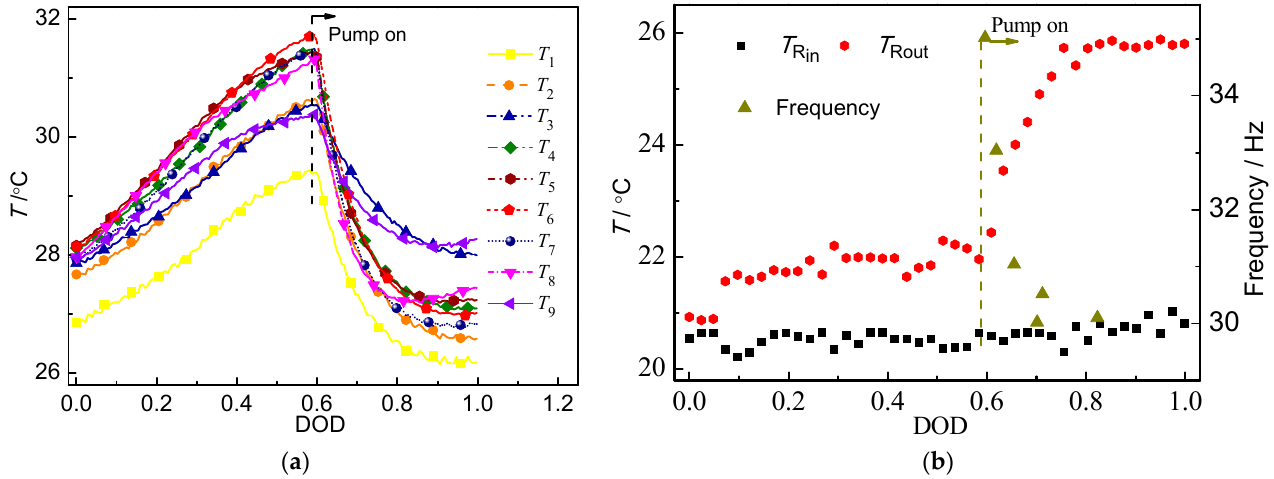
Figure 5. The evolution of ( a ) battery pack temperature and ( b ) refrigerant temperature when the battery module was discharging at 0.6 °C, the pump operates in variable frequency mode.